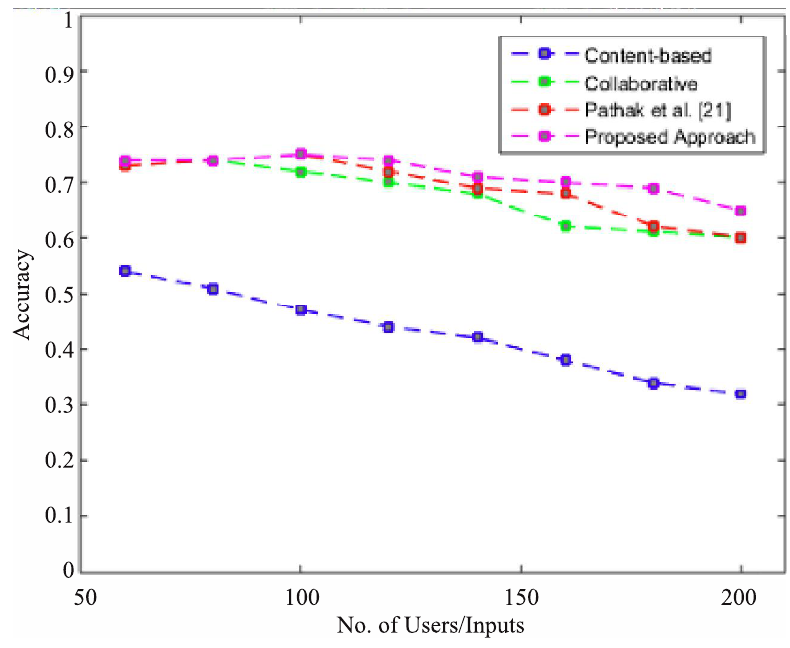
FIG. 5. COMPARATIVE ANALYSIS USING ACCURACY AS EVALUATING